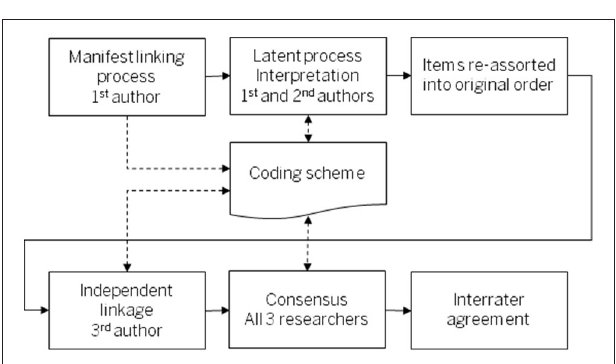
FIGURE 3 | The ICF-CY linking process of the 29 items in the adapted